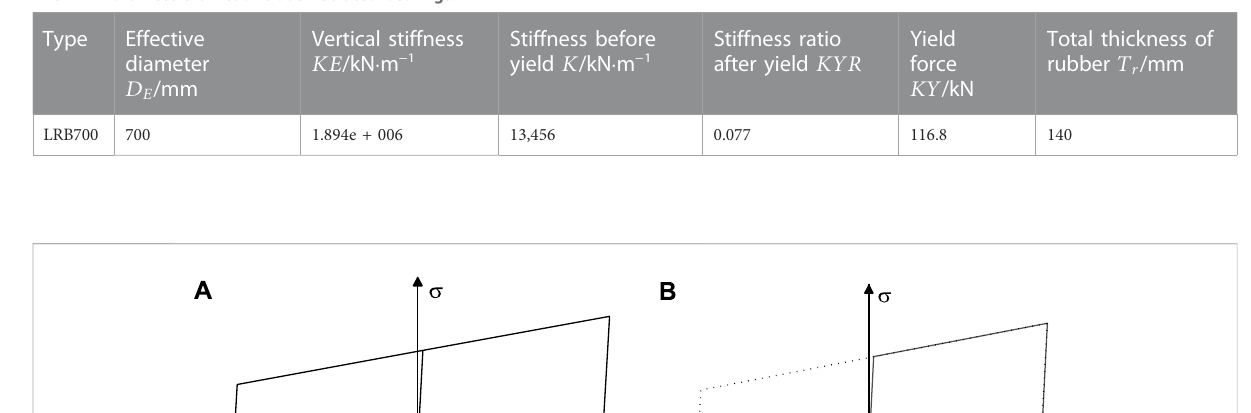
TABLE 1 Parameters of lead-rubber isolated